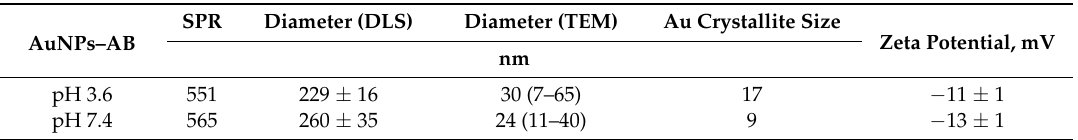
Table 1. Surface Plasmon Resonance (SPR), Hydrodynamic Diameter (DLS), Mean Particle Diameter (TEM), average Au crystallite size (XRPD), and Zeta-Potential Values.